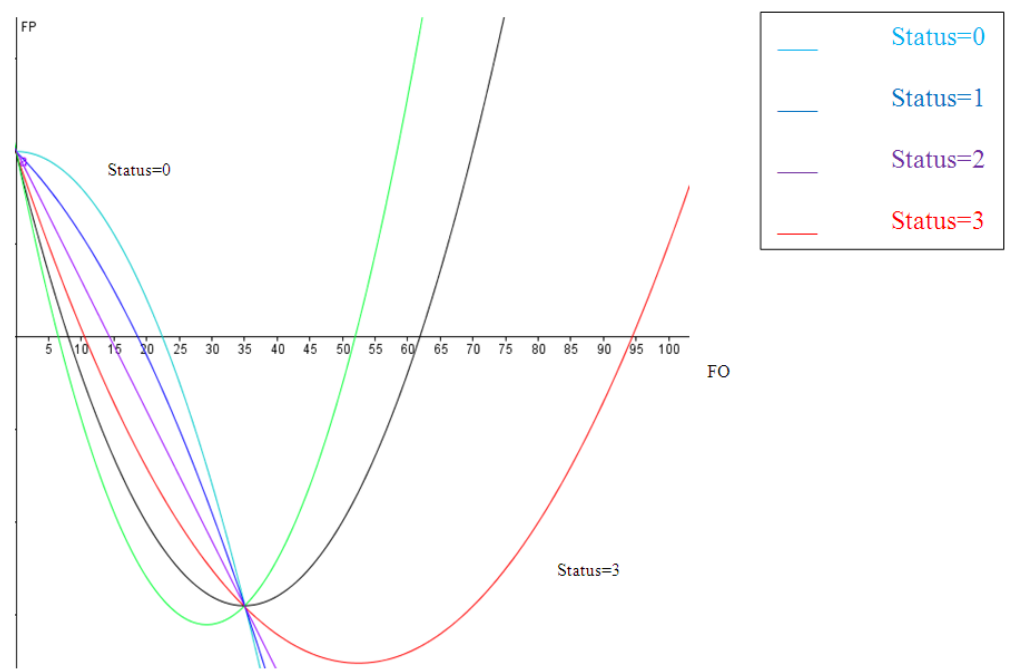
Figure 1. Significant Interactions between Family Ownership and Status Provision. The negative moderation effects of Status Provision changes the direction of inverted U-shaped relationship between Family Ownership and Firm Performance into a U-shape.